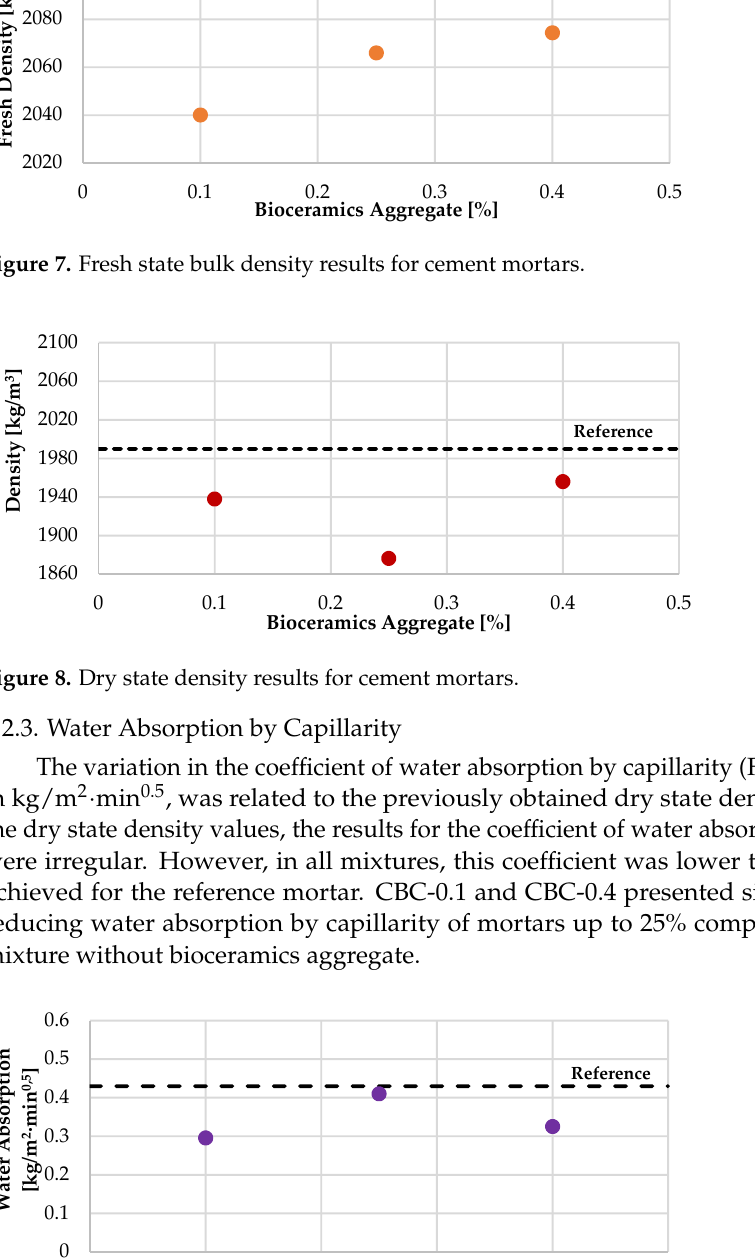
Figure 7. Fresh state bulk density results for cement mortars.